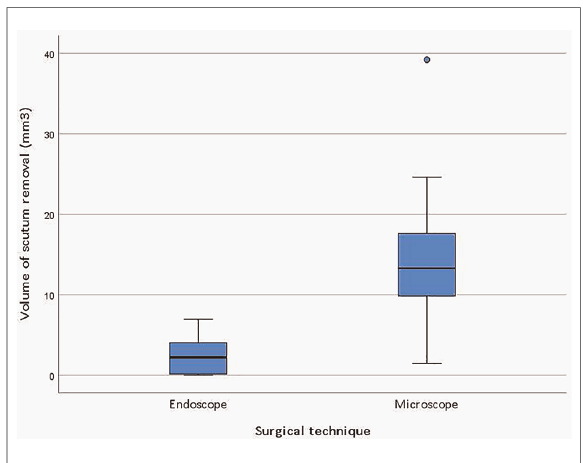
FIGURE 4 Boxplots of the resected scutum volume for the endoscopic ( n = 10) and microscopic ( n = 11) group. The Mann-Whitney U test was used to assess the difference in scutum resection between the two groups ( p =0.001).